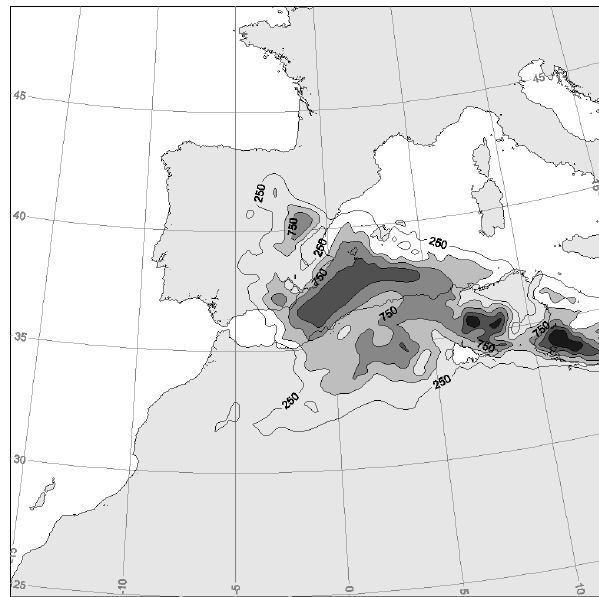
Fig. 11. The 24-h averaged CAPE distribution (J/kg) calculated for the sea level parcels of domain 2 from 12:00UTC 22 to 12:00UTC, 23 October